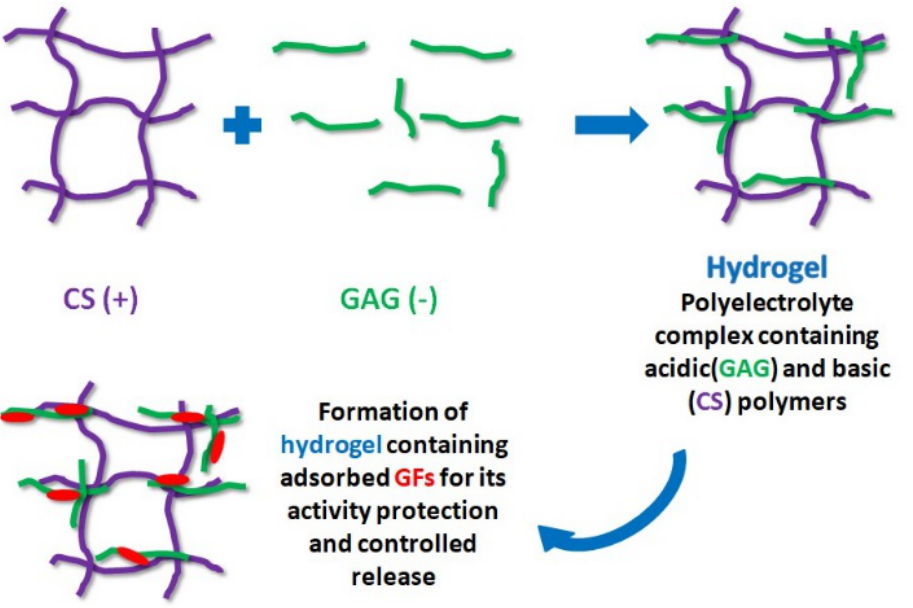
Figure 4. Polyelectrolyte complex containing CS (violet chains) and GAG (green chains) as a substrate for adsorption, activity preservation, and the controlled release of GFs (red macromolecules).